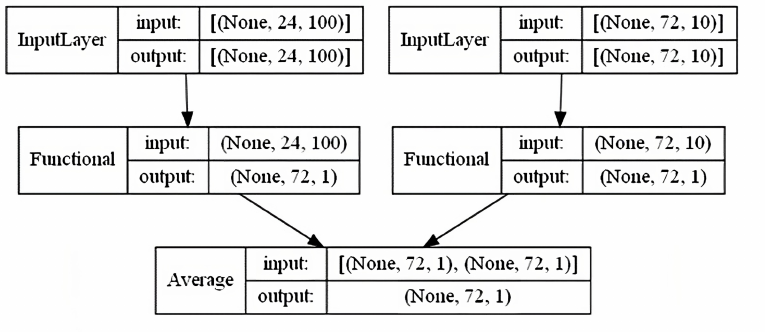
Figure 5. Model architecture: a model that considers both local sensor data and SMHI weather forecast. The functional units include multiple layers which are explained in Figures 6 and